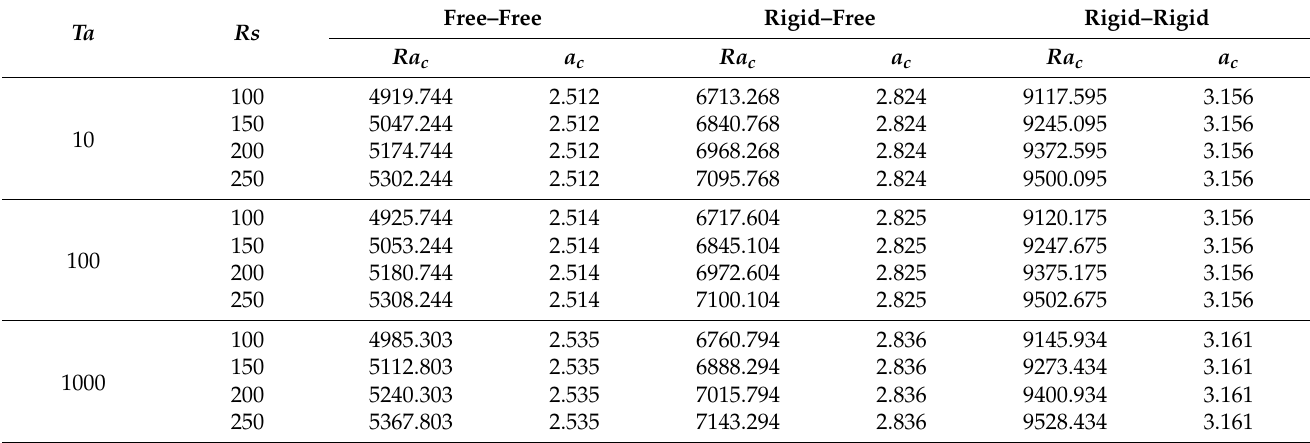
Table 5. Critical values of Ra and a for Da = 0.01, Du = 0.02, Sr = 0.2, Le = 5, Λ = 8, M = 0.9, φ = 0.9.